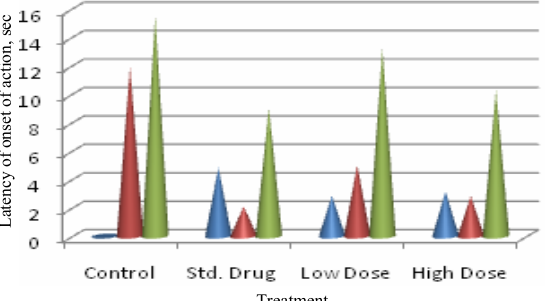
Figure 3. MES induced test on mice of synthetic compound Phenytoin after oral administration